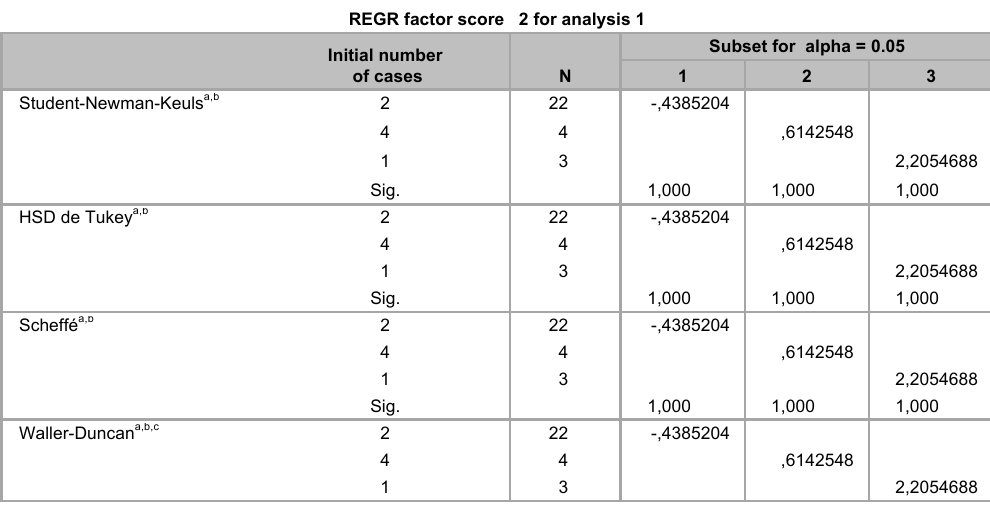
Post-hoc tests for Factor 2 Available base REGR factor score 2 for analysis 1